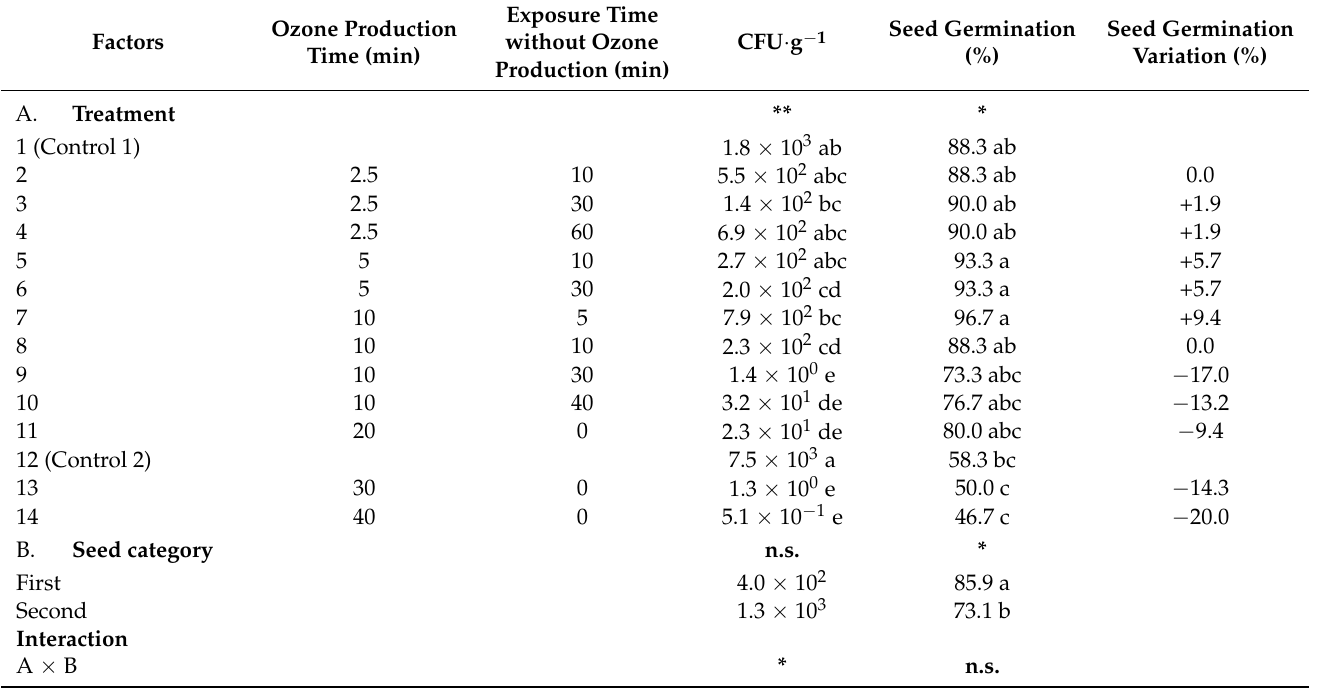
Table 2. Analysis of variance of CFU · g − 1 and seed germination (%) at the end of the in vivo trial with ozone. Ozone treatments were applied to garlic cloves divided in the two quality categories (first category cloves length > 15 mm, second category 10–15 mm clove length). Different letters indicate significant differences according to Tukey’s test ( p < 0.01).